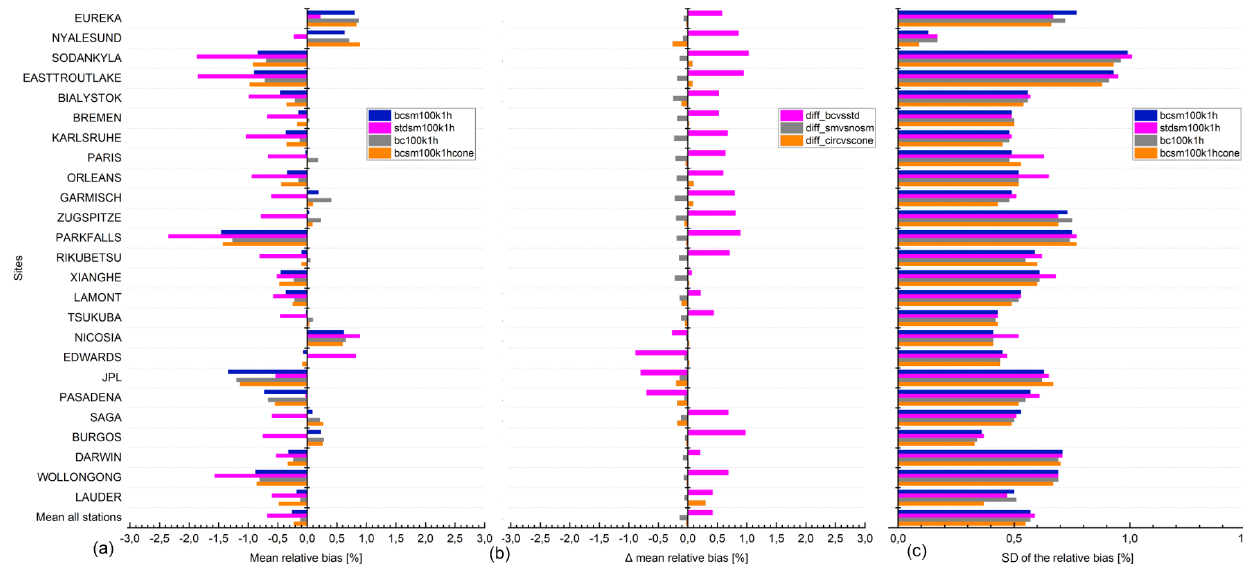
Figure 1. S5P XCH 4 validation results against TCCON XCH 4 data at 25 stations within the period between November 2017 and September 2020. (a) Bar chart of mean relative bias ((SAT – GB)/GB) in percent; (c) standard deviation of the relative bias in percent; (b) difference of the mean relative bias for validation cases (stdsm100k1h, bc100k1h, bcsm100k1hcone) in percent against the reference case (bcsm100k1h) in percent. Spatial co-location with radius of 100km or cone with 1 ◦ opening angle along the FTIR line of sight and time co-location of ± 1h around the satellite overpass were used. The stations are sorted with decreasing